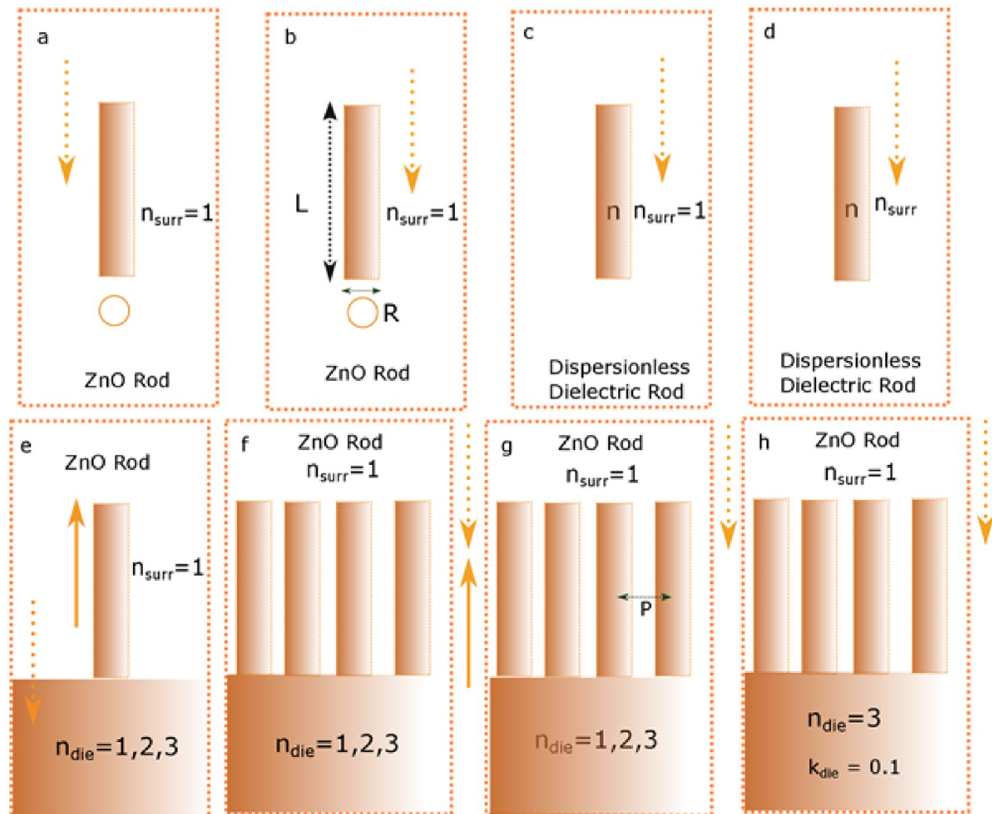
Figure 1. Overview of various configurations of ZnO and dielectric nanorods investigated for in homogenous dielectric and across air dielectric interfaces in the order as examined in this